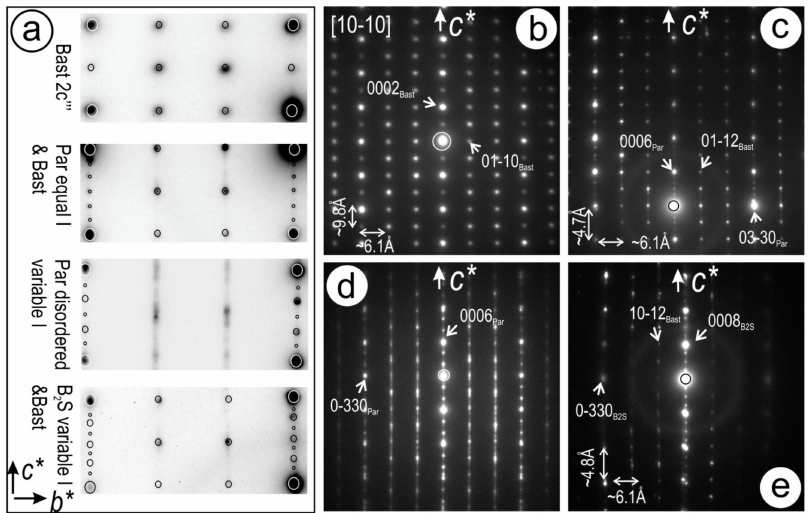
Figure 5. ( a ) Two-dimensional sections through the reciprocal lattice of studied BSG species and their intergrowths (as marked) showing the distribution of satellite reflections on [10 − 10] zone axis selected from SAEDs in ( b – e ); Note the orthogonal patterns indicating a hexagonal lattice in all cases; ( b – e ) SAEDs on [10 − 10] zone axis for bastnäsite ( b ); intergrowths between parisite and bastnäsite ( c ); disordered parisite ( d ); and intergrowths between B 2 S and bastnäsite ( e ); Note the ordered 2-fold (or 2 c (cid:48)(cid:48)(cid:48) ) bastnäsite obtained by tilting the same grain shown for SAED on [ − 1100] zone axis in Figure 4c. The SAEDs in ( c – e ) represent intergrowths imaged on the same zone axis in Figure 10. Bast—bastnäsite; I—intensity;